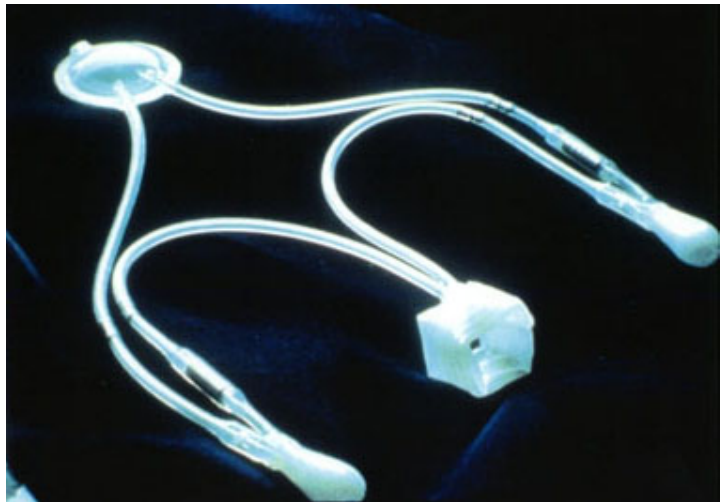
FIGURE 4 . Brantley-Scott AS-721 artificial urinary